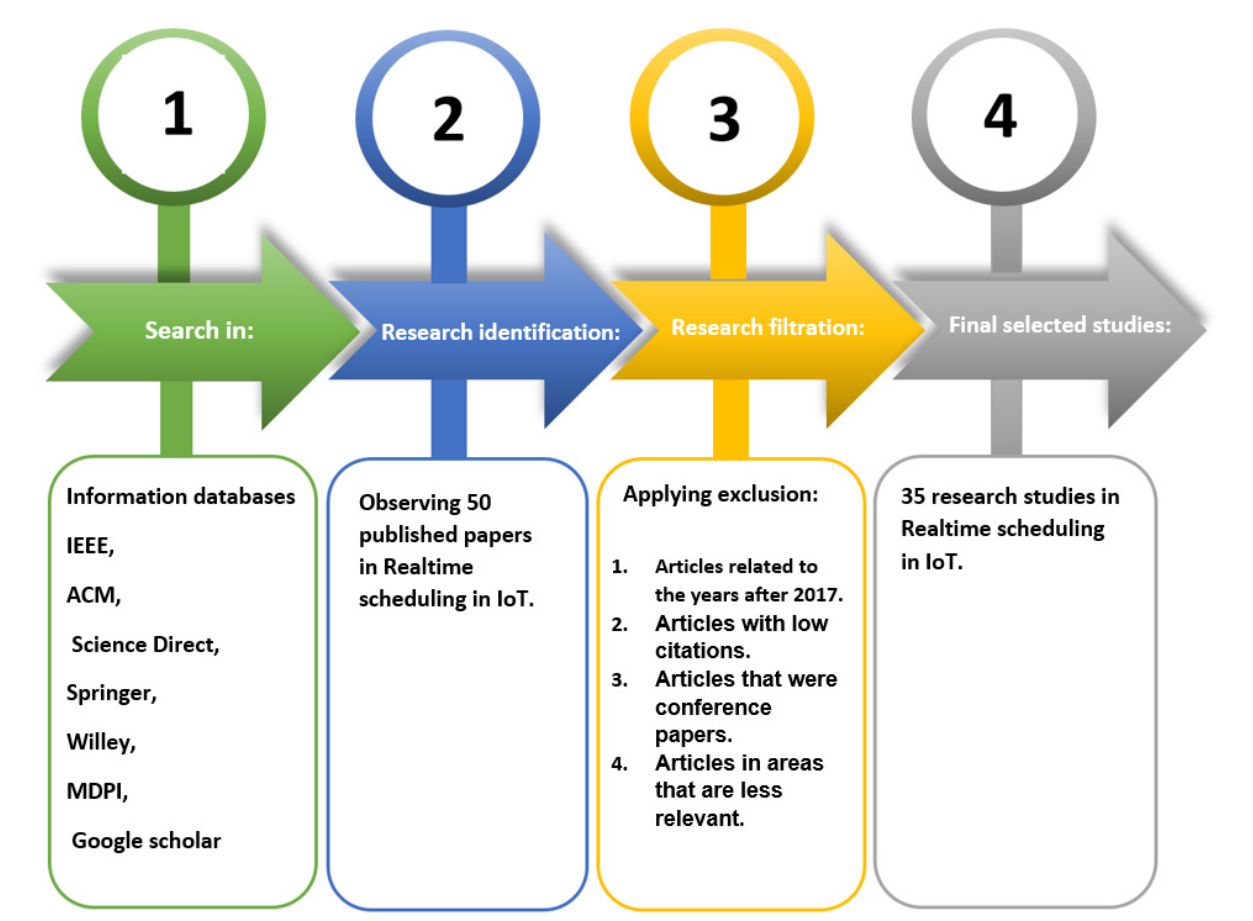
Figure 3. Study selection of the real ‐ time scheduling in IoT.